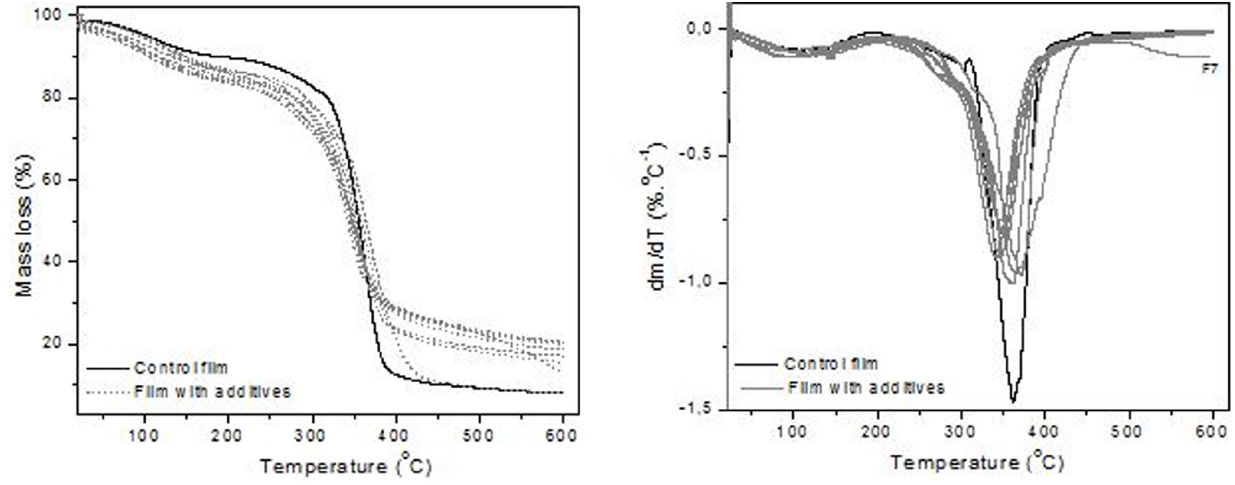
Figure 3. TG (A) and DTG (B) curves for the control film and the film with different additives concentrations.